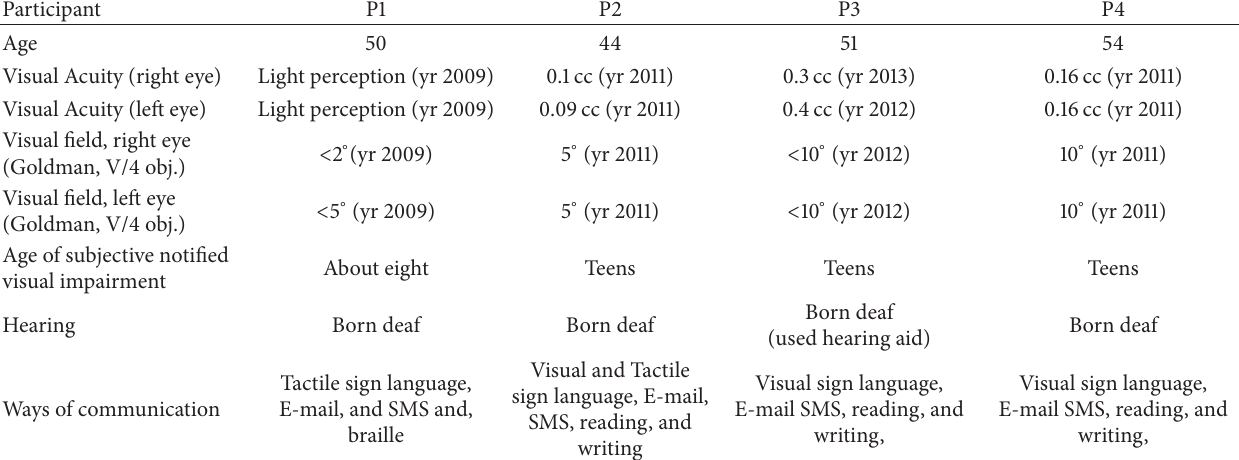
Table 1: Anamnestic information of the four female participants with Usher’s Syndrome I (P1, P2, P3, and P4).